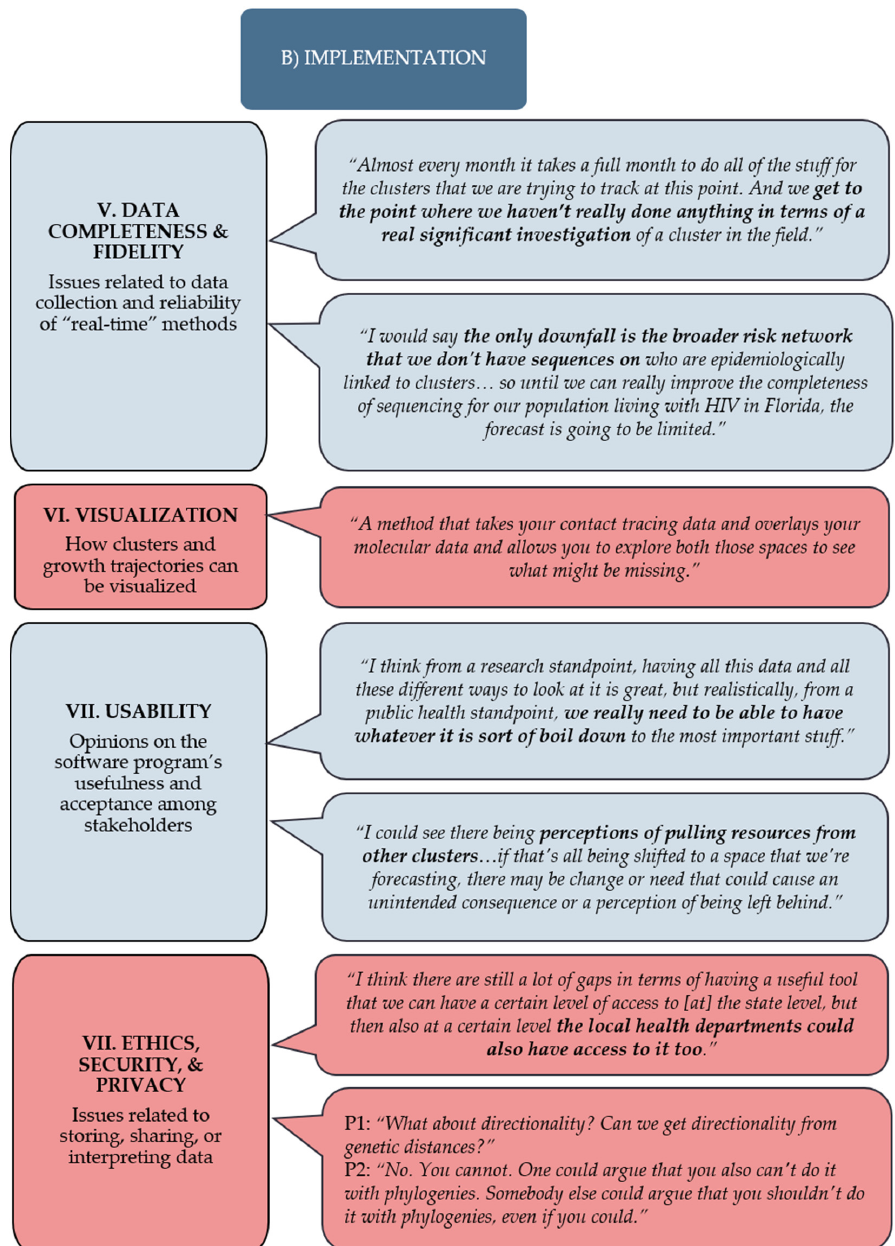
Figure 2. Implementation subthemes and noteworthy quotes from the focus group participants with varying expertise in HIV molecular epidemiology and public health surveillance.